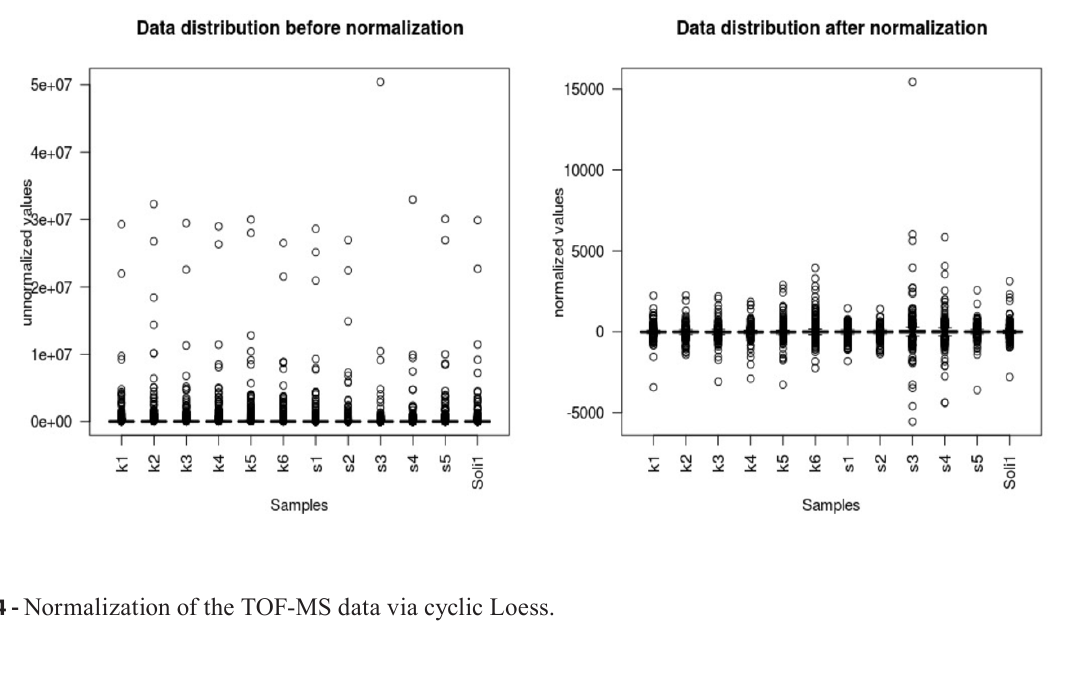
FIGURE 4 - Normalization of the TOF-MS data via cyclic Loess.